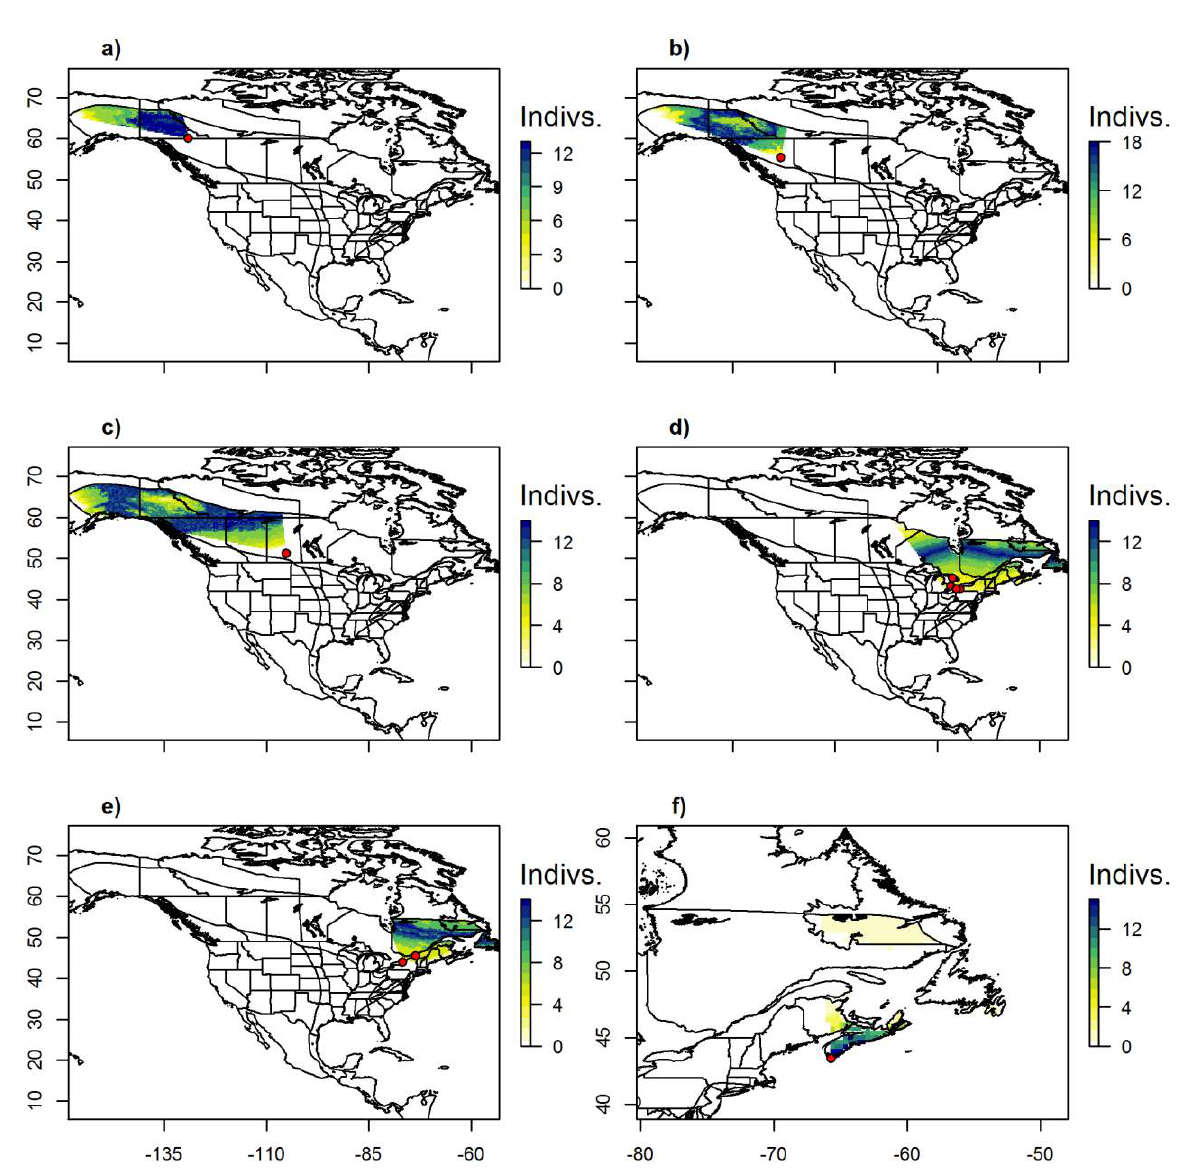
Figure A2.1: Probable origins of hatching year (HY) Alder Flycatchers ( Empidonax alnorum ) captured during fall migration at CMMN stations in a) the Yukon (ACBO (n=20)); b) Northern British Columbia (MNO (n=20)); c) Saskatchewan (LMBO (n=20)); d) Southwest Ontario (AuBO (n=1), BPBO (n=1), HBO (n=7), LPBO (n=6), TTPBRS (n=5)); e) Southeast Ontario & Southwest Québec (MBO (n=8), PEPTBO (n=12)) and f) Eastern Canada (ABO (n=20)